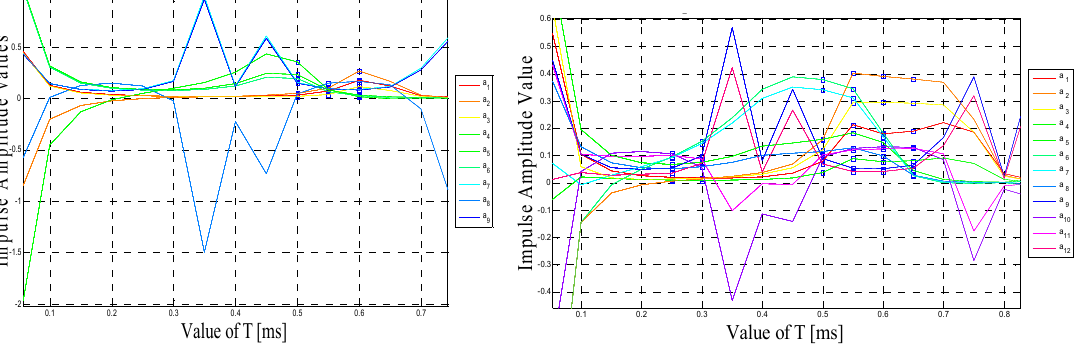
Figure 3. Shapers’ impulse amplitudes versus T for three-impulses ( left ) and four-impulses ( right ) schemes.